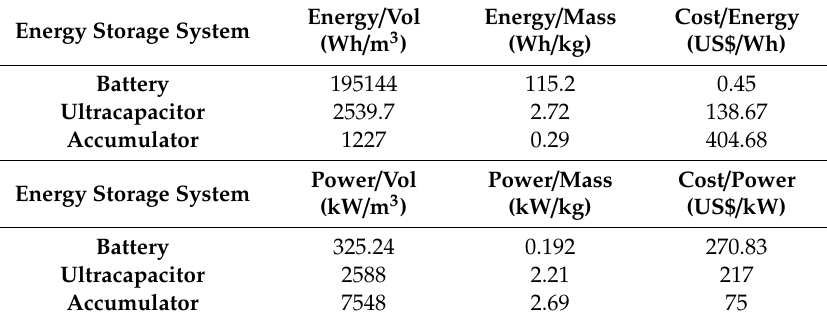
Table 13. Energy density and power density.